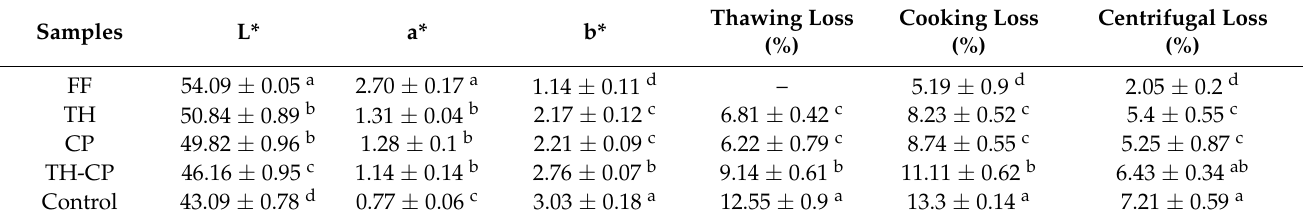
Table 3. Effects of different treatments on the color and WHC of fillets induced by freeze-thaw